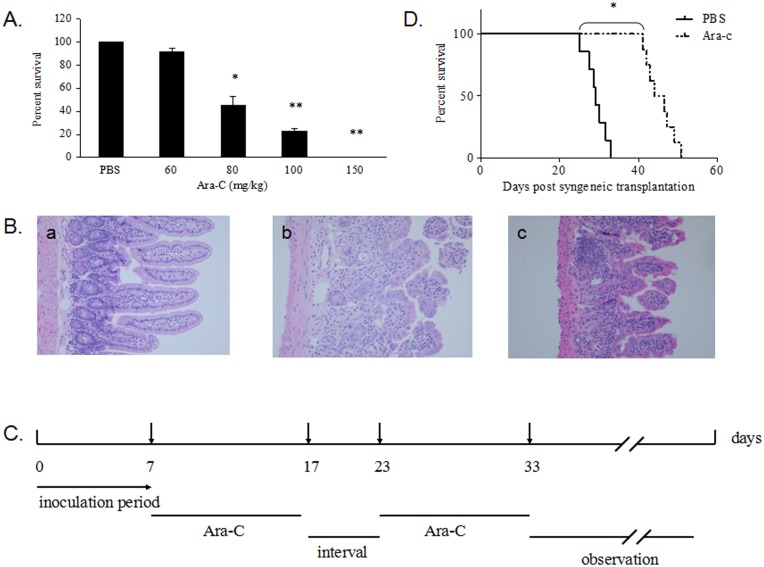
Development of an efficacious Ara-C-based regimen for the treatment of AML in mice.Fig. 2A) The survival rate of mice treated with Ara-C at various doses or with 100 µL of PBS control, in accordance with the treatment scheme described in the text. The mice were watched for a period of 50 days. The results shown here are representative of data obtained from 3 separate experiments. Fig. 2B) Histopathological examination of intestine affects Ara-C treatment. Fig. 2C) Treatment protocol for AML mice. The day of infusion of leukemic cells was considered as day 0. Fig. 2D) Suppression of leukemia using the treatment protocol. B6C3F1 mice transplanted with 2×105 B117P cells via tail vein were treated with either Ara-C (n = 12) or PBS (n = 12) as the control. *p<0.05.